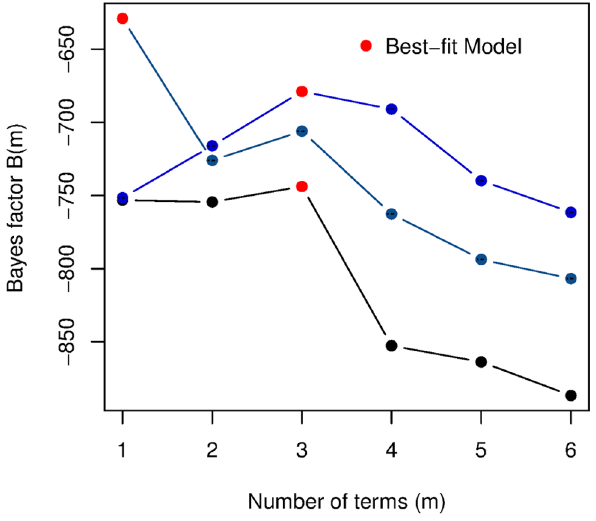
Figure 7. Bayes factor plots. For the two-variable dG models (black), the three-variable dG models with lag GDP per capita ( G t { 1 ) (violet) and the three-variable dG models with G t { G t { 1 as the third indicator variable (blue).